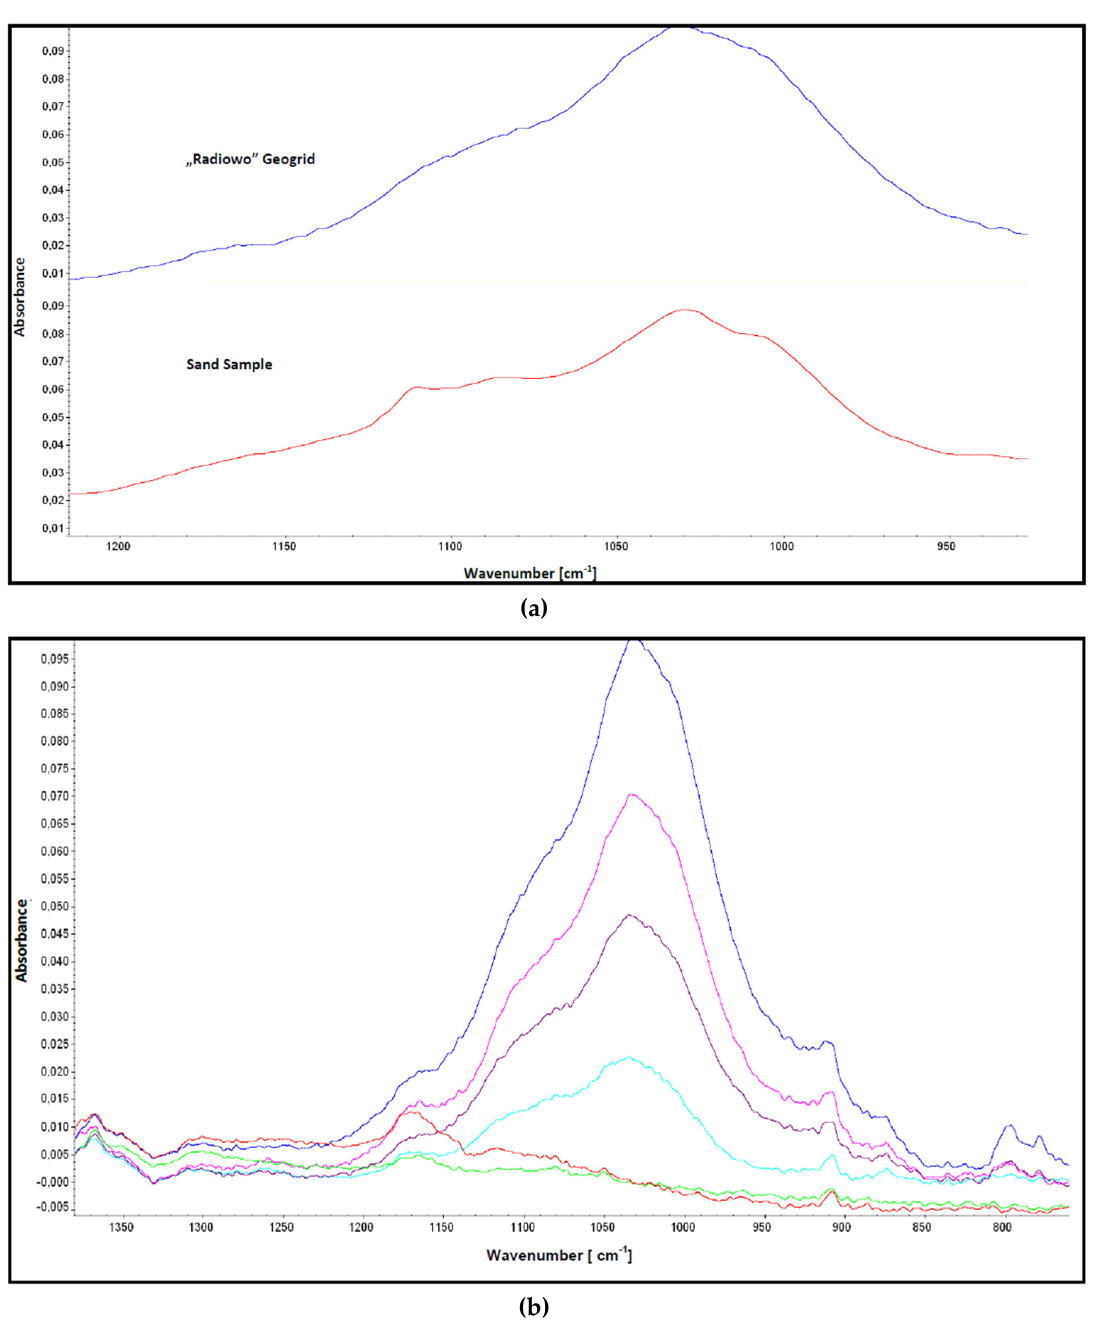
Figure 9. ( a ) Corrected spectra for aged geogrids samples and ( b ) corrected spectra for “sample sand” (silicates).